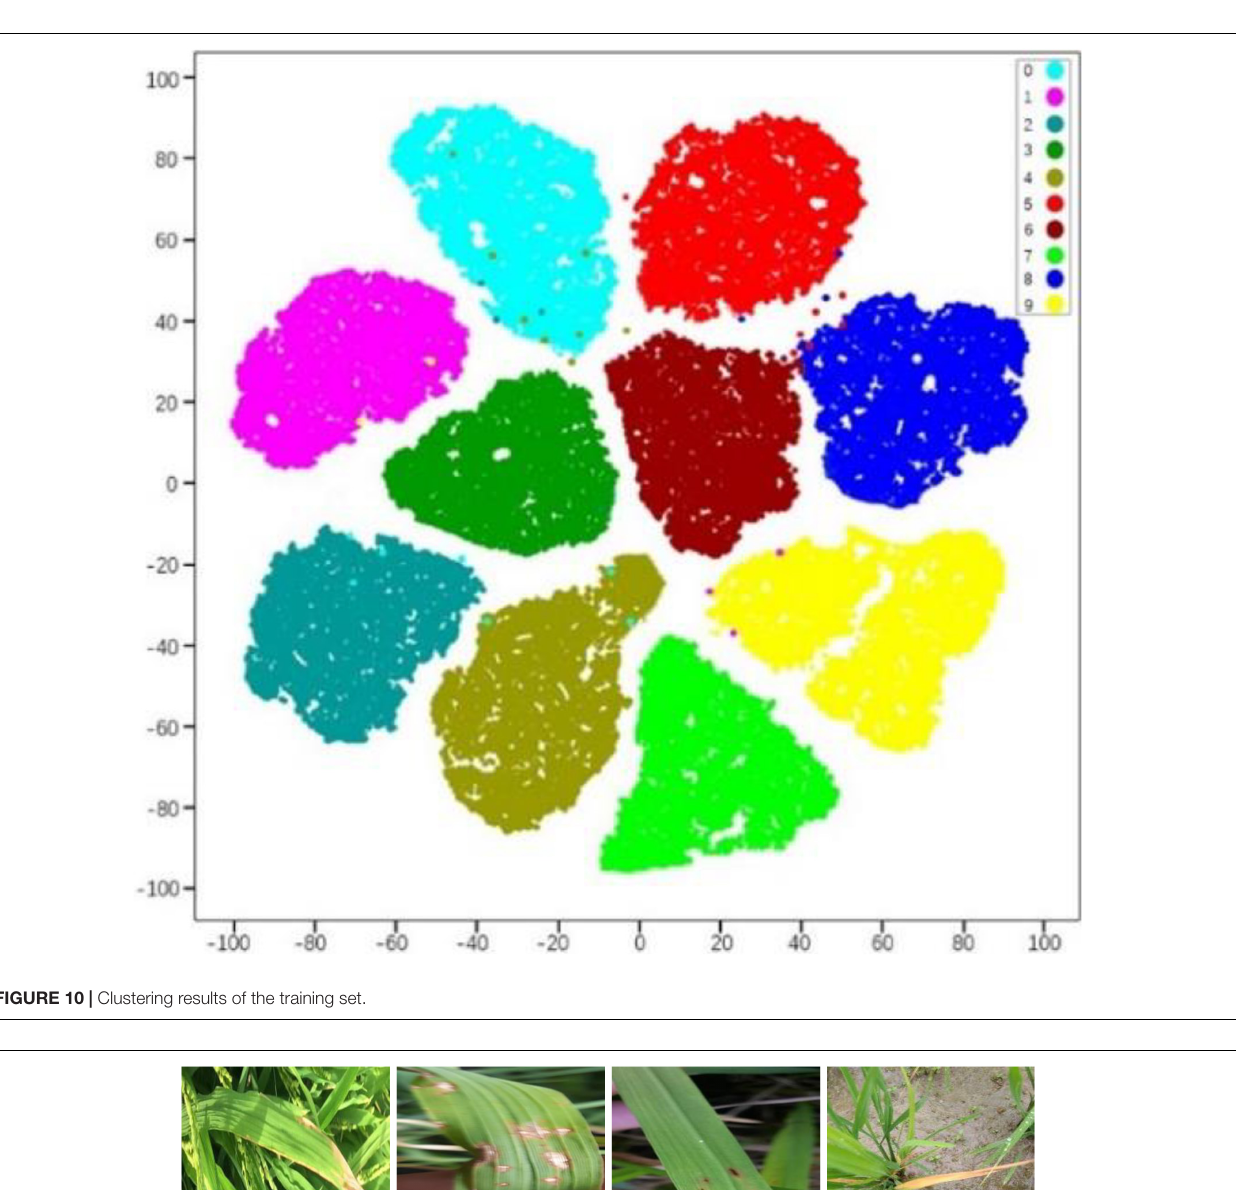
FIGURE 11 | Sample images of the rice leaf